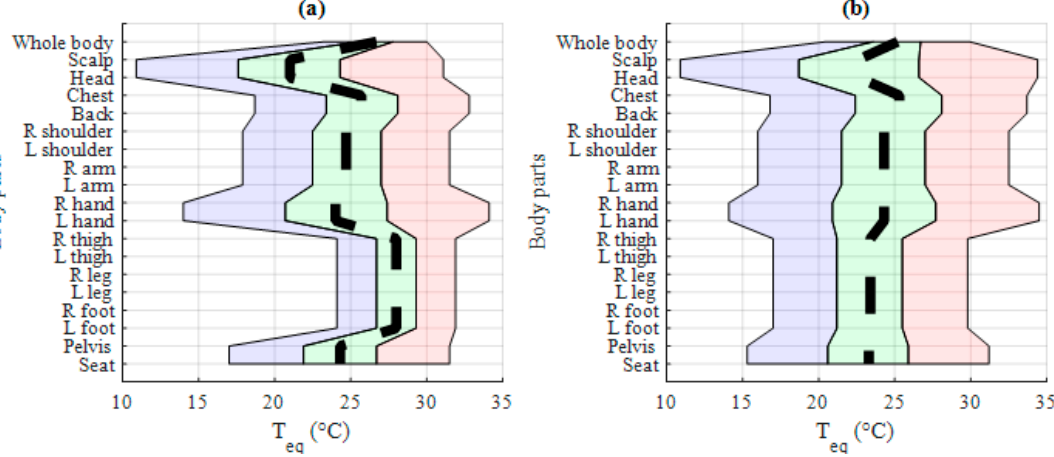
Figure 1. Comfort zone diagram for a driver: ( a ) informal summer dress, ( b ) formal summer dress.